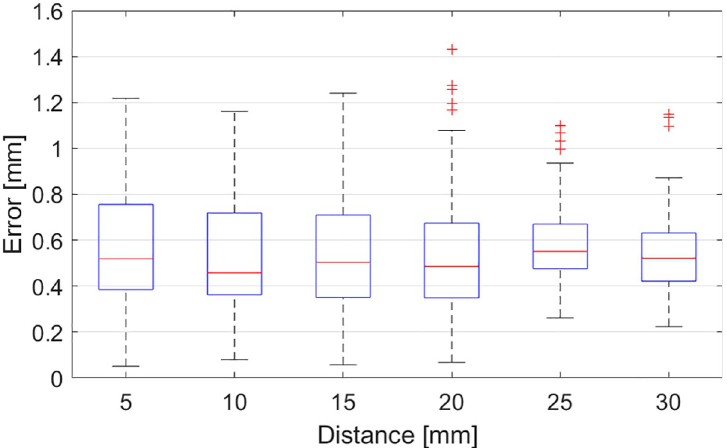
Fig 8. Boxplots of the errors in the image overlay as a function of the distance of the endoscope from the grid.